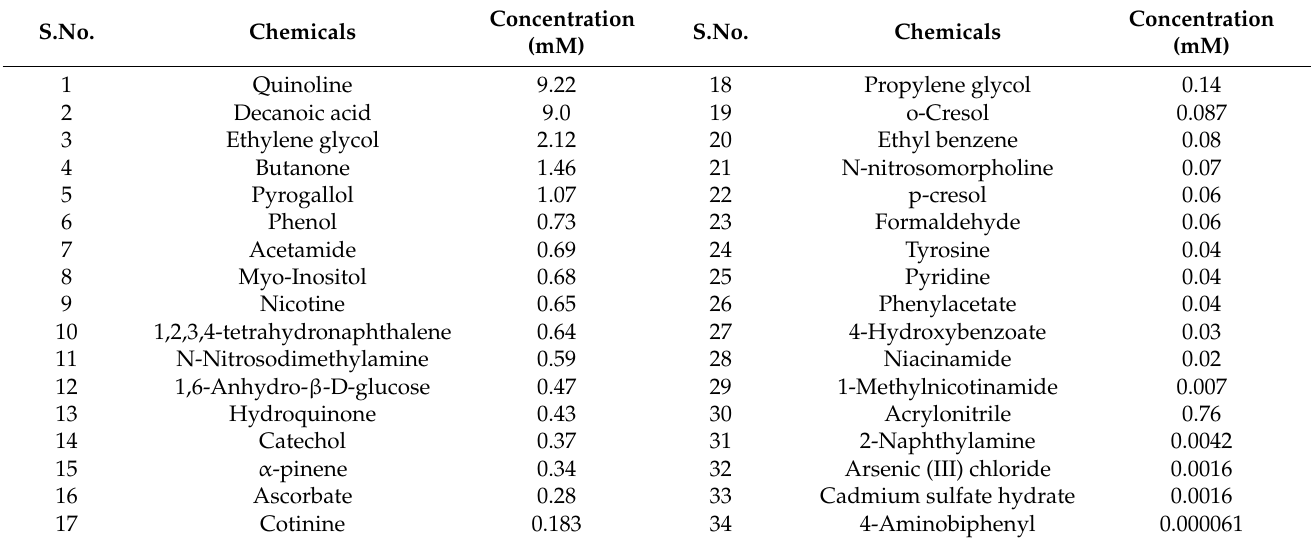
Table 1. Chemicals detected in CSC and their concentrations that were screened for impact on muscle mitochondrial